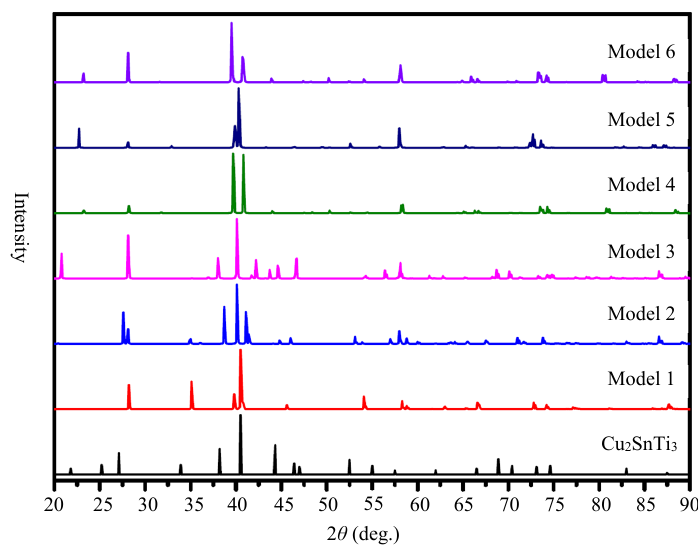
Figure 6. Comparison of XRD of Cu 2 SnTi 3 and DFT simulated XRD of Models 1–6.